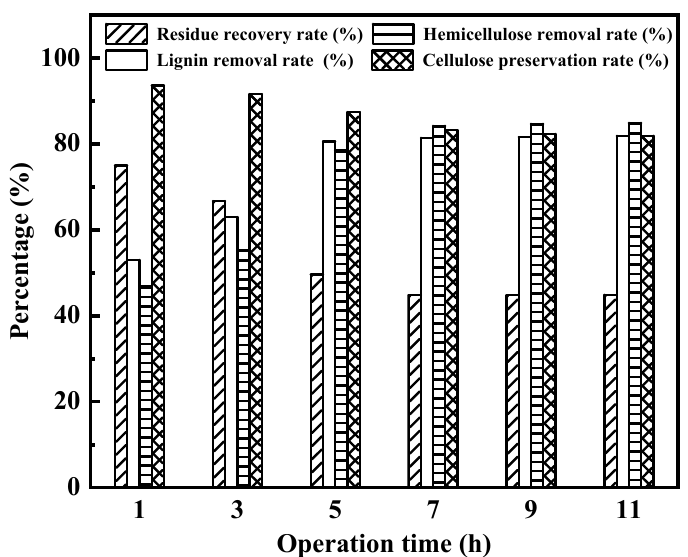
Figure 7. Influence of operation time on enhancing enzymatic hydrolysis of wheat straw.